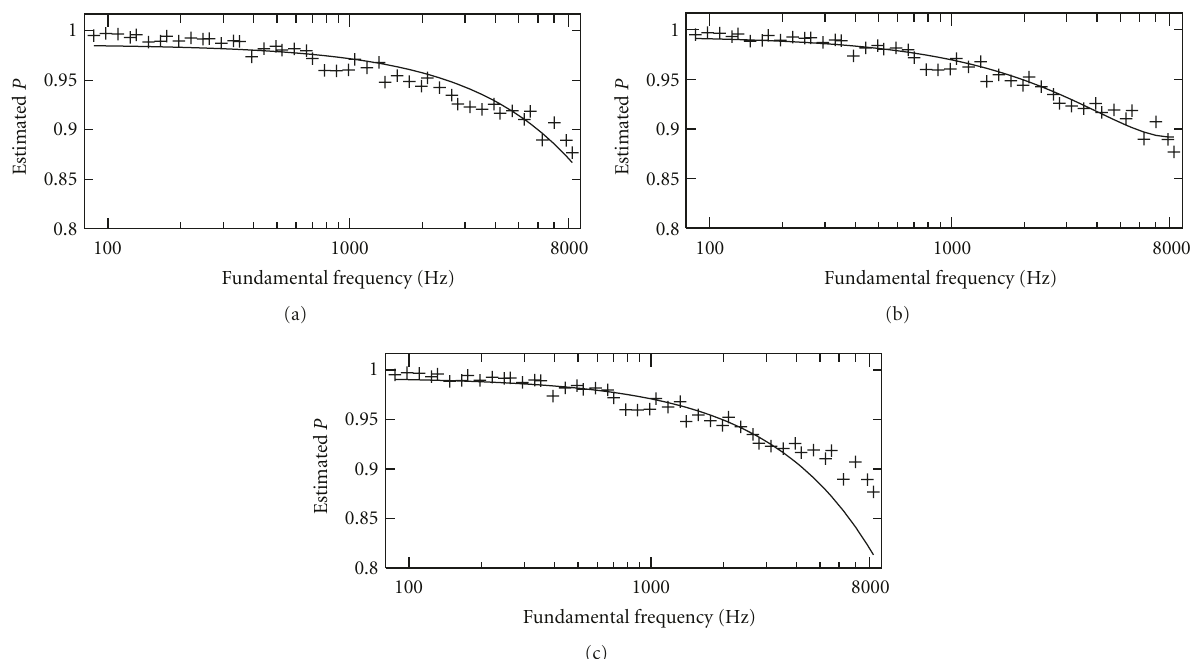
Figure 4: Phase distortion (PD) model parameter estimate means (plus signs) and (a) a first-order and (b) a second-order fit to the estimate data using all data points. (c) A first-order fit to the estimate data using data points below